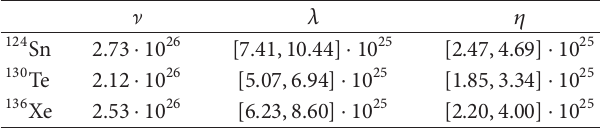
Table 5: Calculated half-lives (𝑇 1/2 ) intervals for each mechanism expressed in years. The range of the interval corresponds to the uncertainty in the CP phases 𝜙 1 and 𝜙 2 in